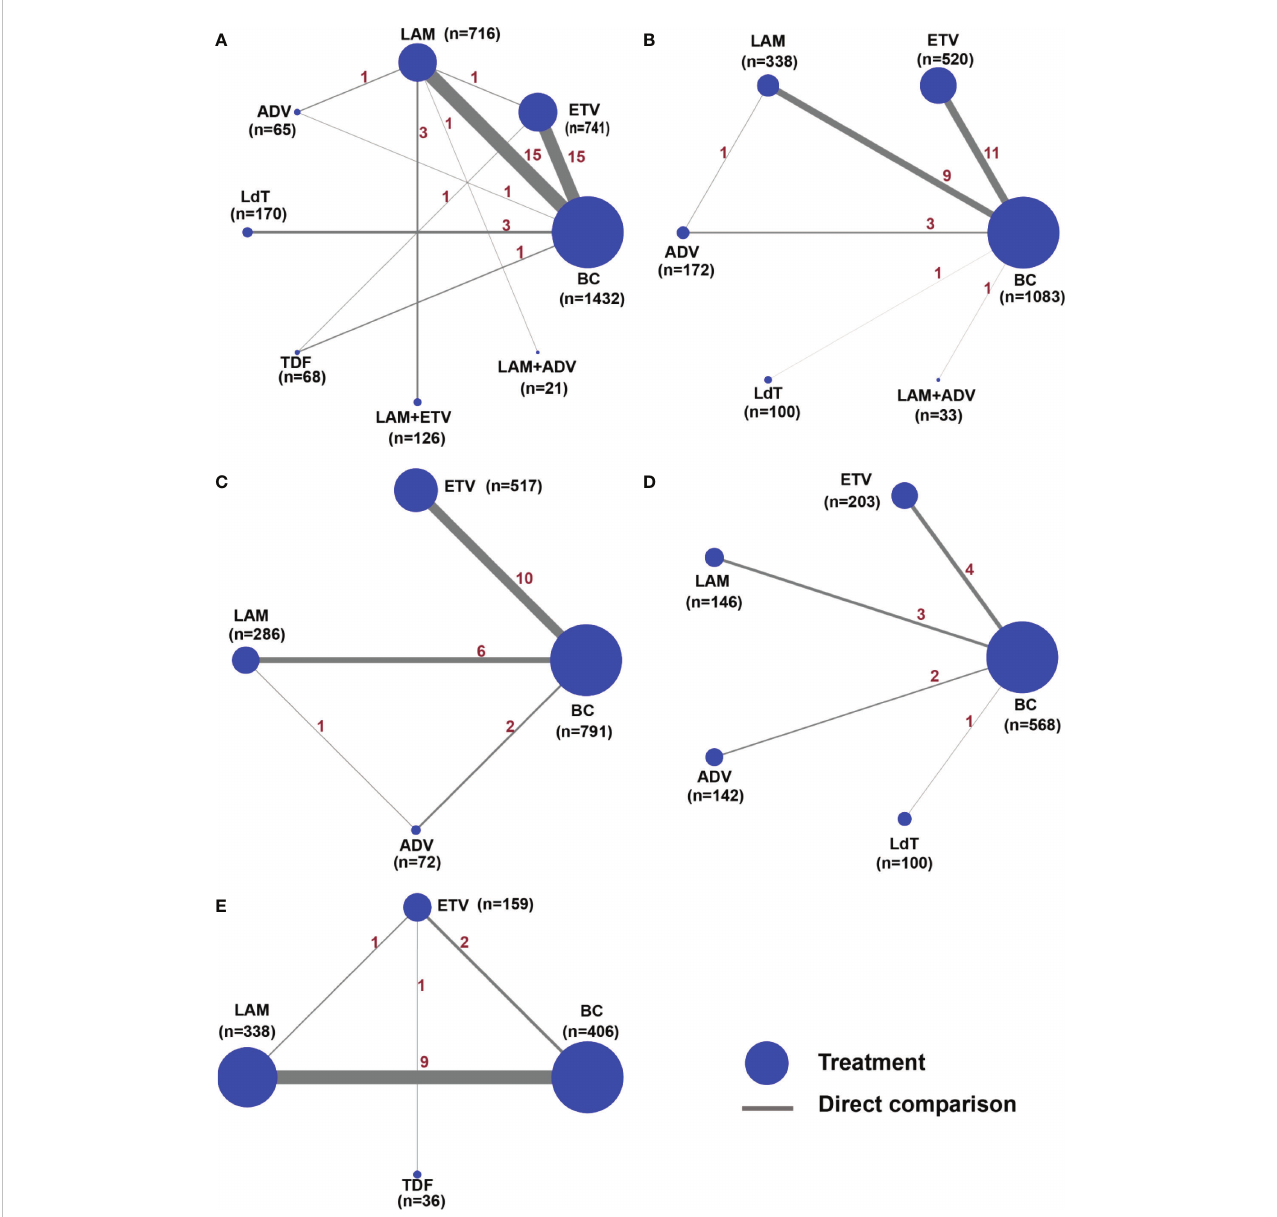
FIGURE 2 Network structure map for all outcome indicators. The network plots show a direct comparison of the different treatments, whereby the node size corresponds to the sample size. The thickness of solid lines re fl ects the number of studies included in the speci fi c direct comparison for the following outcome indicators. (A) HBV reactivation rate, (B) 1-year survival rate, (C) 2-year survival rate, (D) 3-year survival rate, and (E) chemotherapy disruption